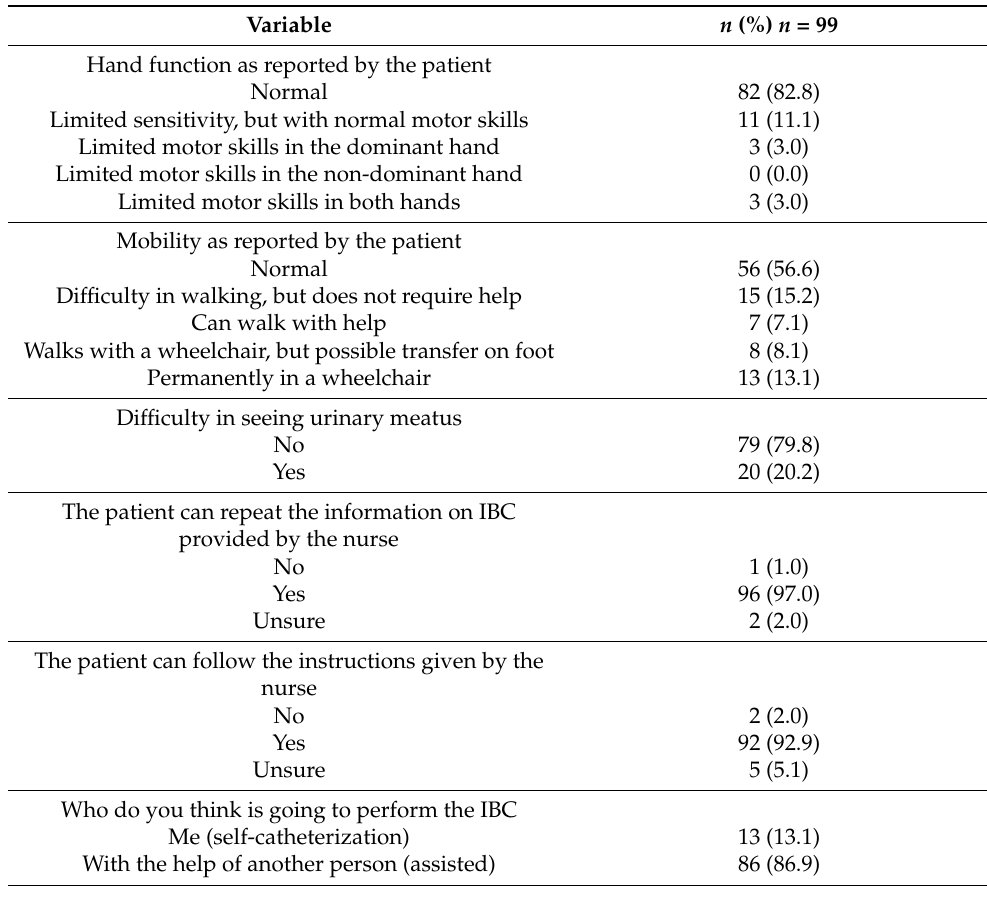
Table 3. Characteristics related to self-care